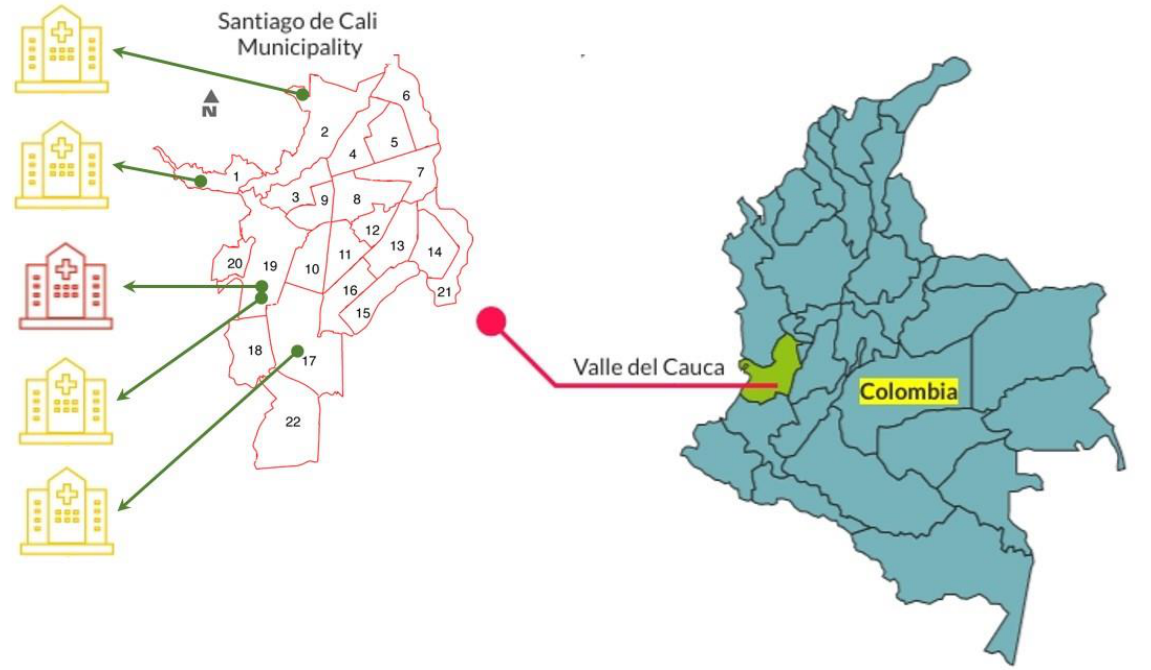
Figure 1. Location of the hospitals from which E. cloacae complex isolates were obtained. Four of them are private (in yellow) and one is public (in red); all are in four communes of the municipality of Santiago de Cali, Department of Valle del Cauca, Colombia (Made through https://www.visme.co/, accessed on 29 March 2021). Additionally, Table 1 presents the information related to the clinical isolates (year of isolation and hospital of origin) and the demographic data associated with the samples (age and sex of the patient and site of